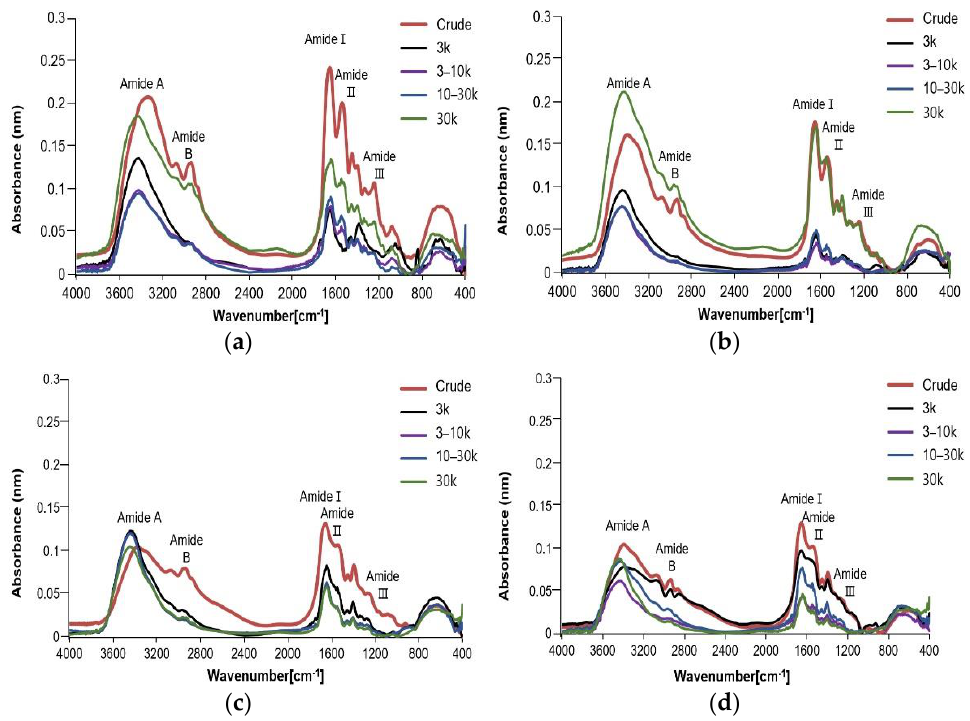
Figure 4. FTIR spectrum of collagen hydrolysate fractions extracted from APS. ( a ) Control; ( b ) Ultrasound assisted extraction method; ( c ) Enzyme assisted extraction method; ( d ) Combination of enzyme and ultrasound assisted extraction methods.